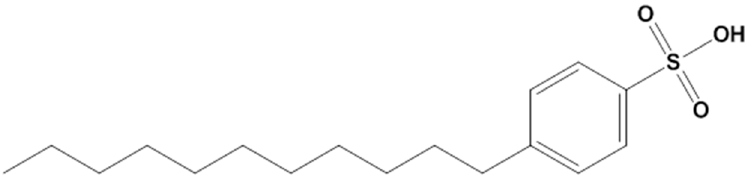
Figure 1. Undecylbenzenesulfonic